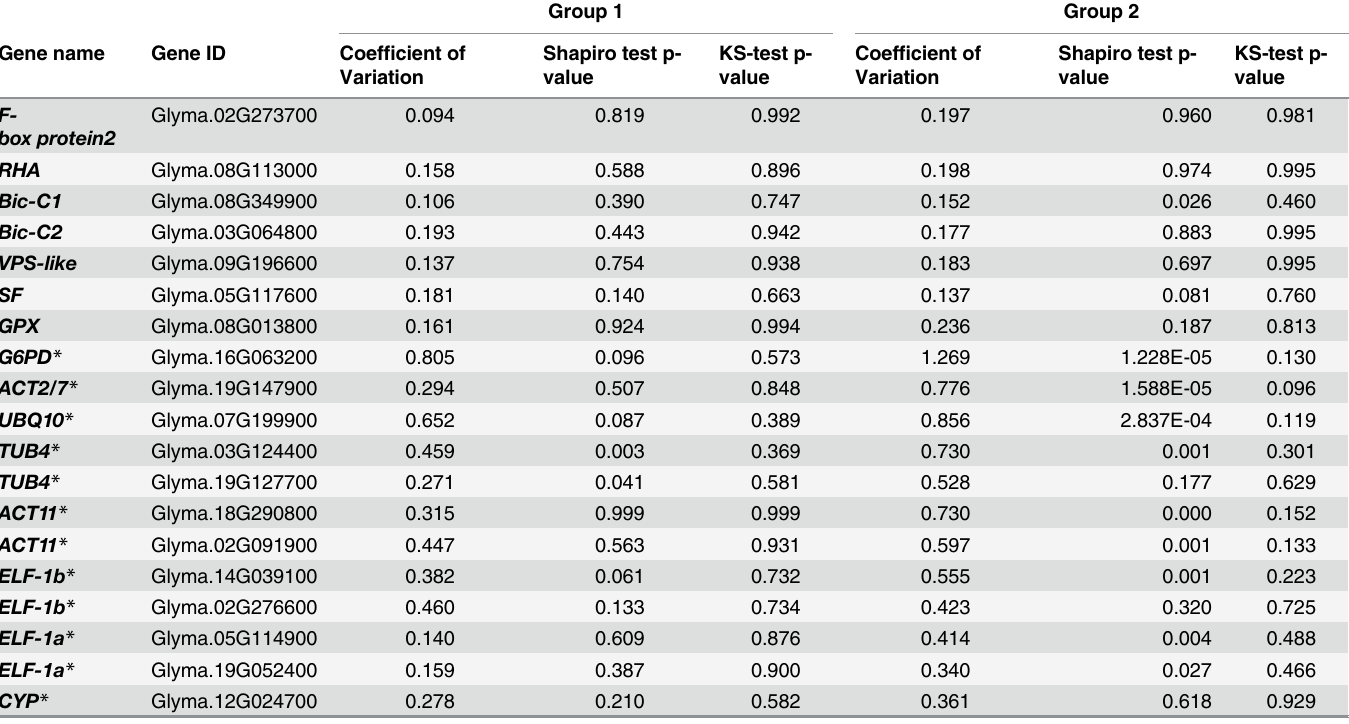
Table 2. Evaluation of selected reference genes using RNA-Seq